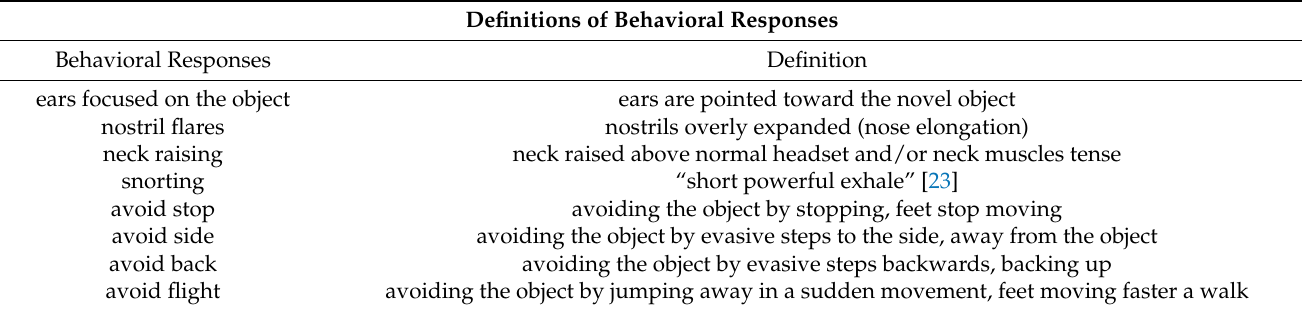
Table 2. Behavioral responses and definitions used for behavioral analysis.